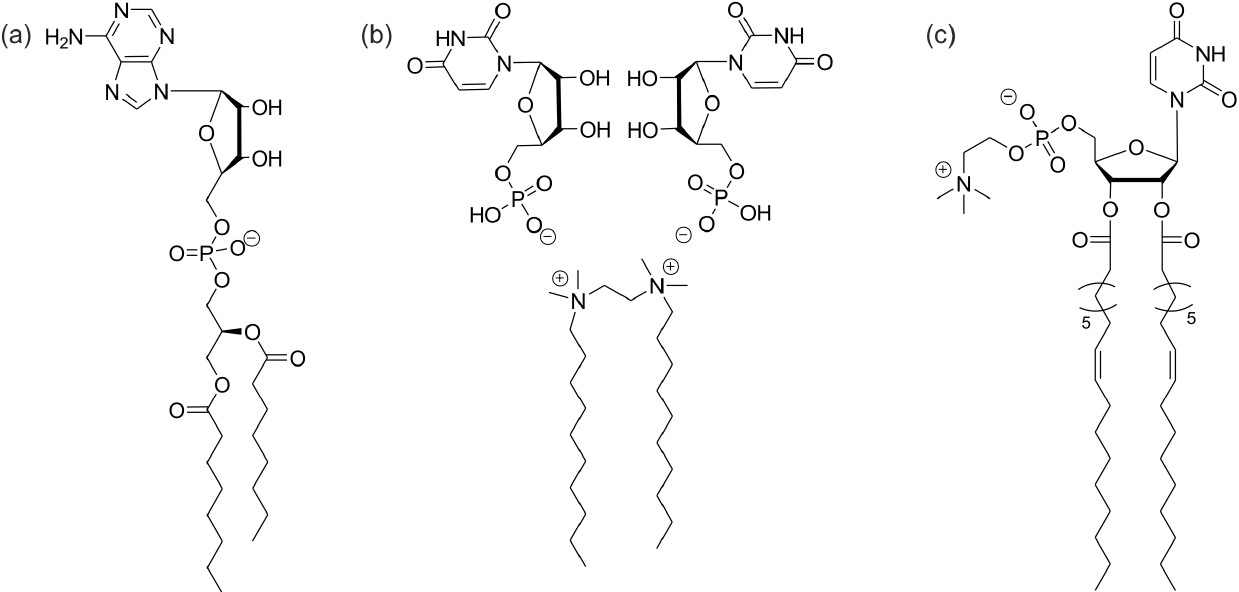
PA [37]; ( b ) a gemini 8